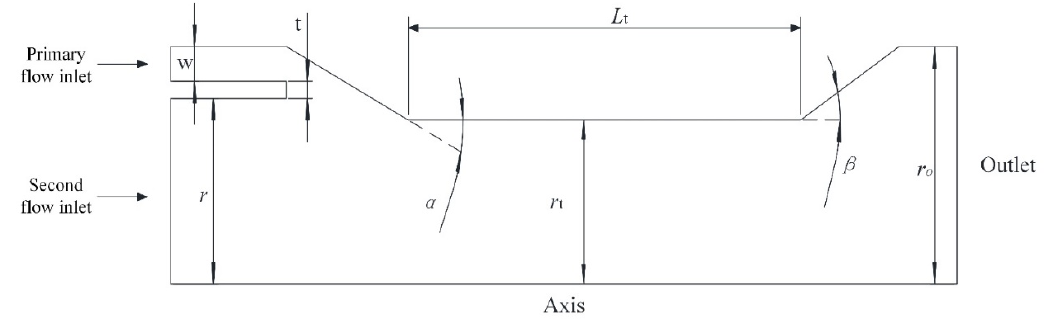
Figure 2. The calculation domain.